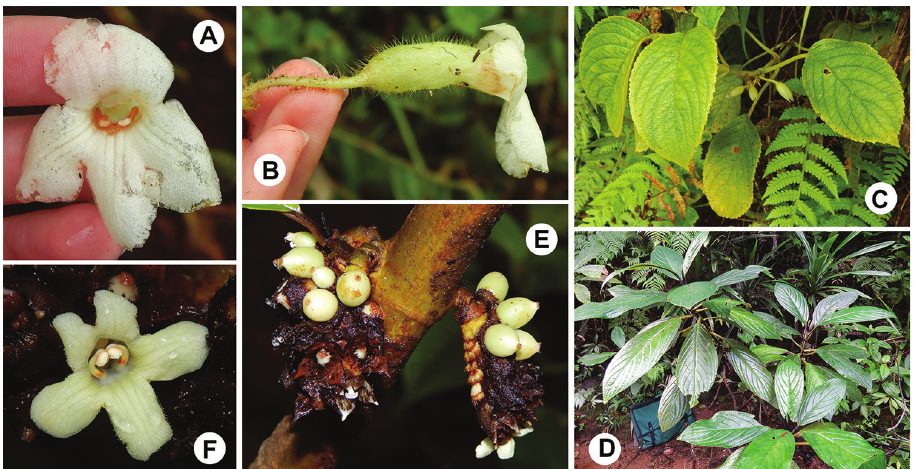
Figure 6. Cyrtandra hispida M.A.Johnson and closest relative ( C. cephalophora ) based on molecular phy- logeny by Johnson et al. (2017). A C. hispida corolla, anterior view B C. hispida flower, lateral view C C. hispida shrub habit and axillary cyme inflorescence D C. cephalophora shrub habit E C. cephalophora capitate-cylindrical cauliflorous inflorescence and young fruits F C. cephalophora corolla, anterior view. All photos taken in the field by M. Johnson, with photos of C. hispida taken from the type